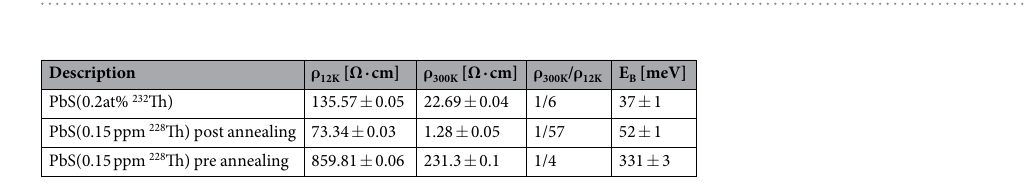
Table 1. Sample resistivities and extracted barrier energies (E B